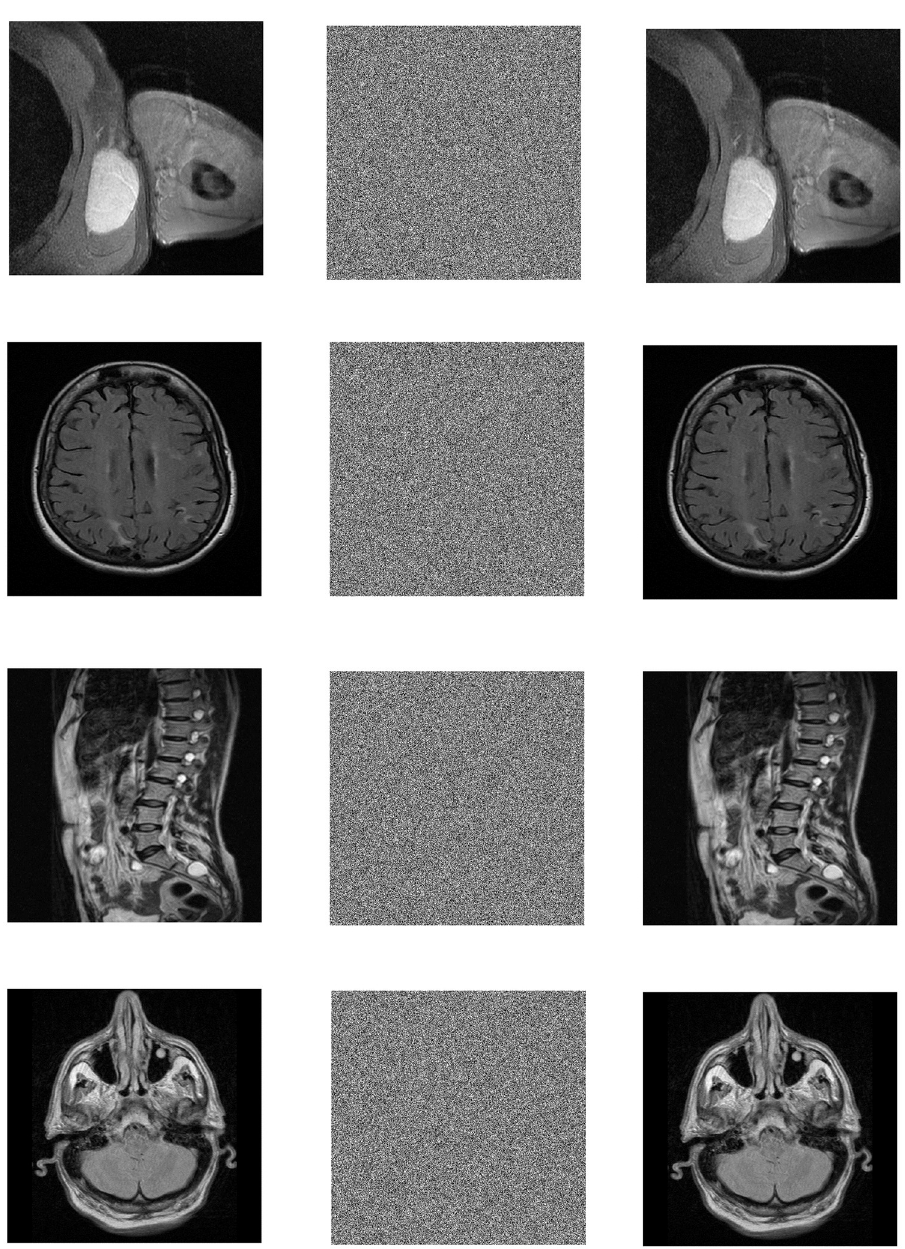
Fig 6. Simulation results of MRI images. (a) Axillaty encrypted image, (b) Axillaty encrypted image, (c) Axillaty decrypted image, (d) Brain original image, (e) Brain encrypted image, (f) Brain decrypted image, (g) Lumbar original image, (h) Lumbar encrypted image, (i) Lumbar decrypted image, (j) Patient brain original image, (k) Patient brain encrypted image, (l) Patient brain decrypted image.